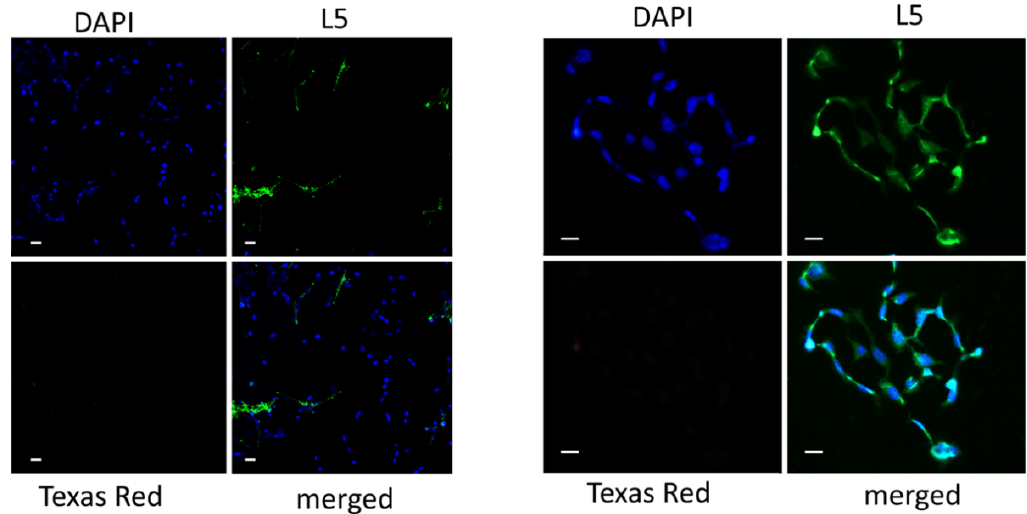
Figure 5. Fluorescence microscope images of hFOB 1.19 incubated with Curc ( left ) and with Curc@MSN ( right ). Bar = 1 μ m.